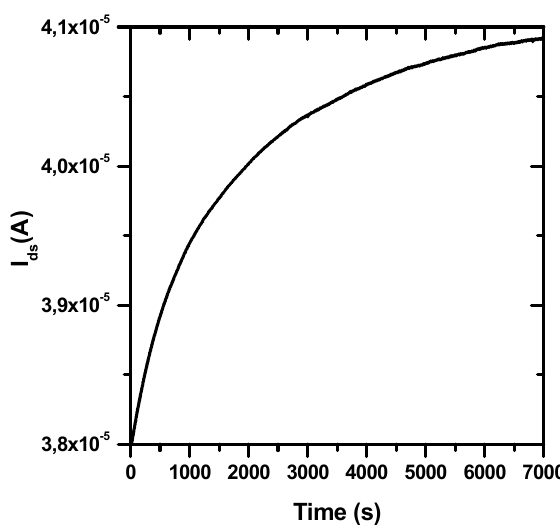
Figure 4. Representative behaviour of the drain-source current (I ds at constant V ds = 100 mV) measured by an n-type MOSFET whose gate electrode is connected with a biofunctionalized gold extended gate immersed in an electrolyte solution (PBS 100 mM solution, pH 8.0), upon the application of a constant voltage (V ref = 400 mV) through a bulky Ag/AgCl reference electrode.